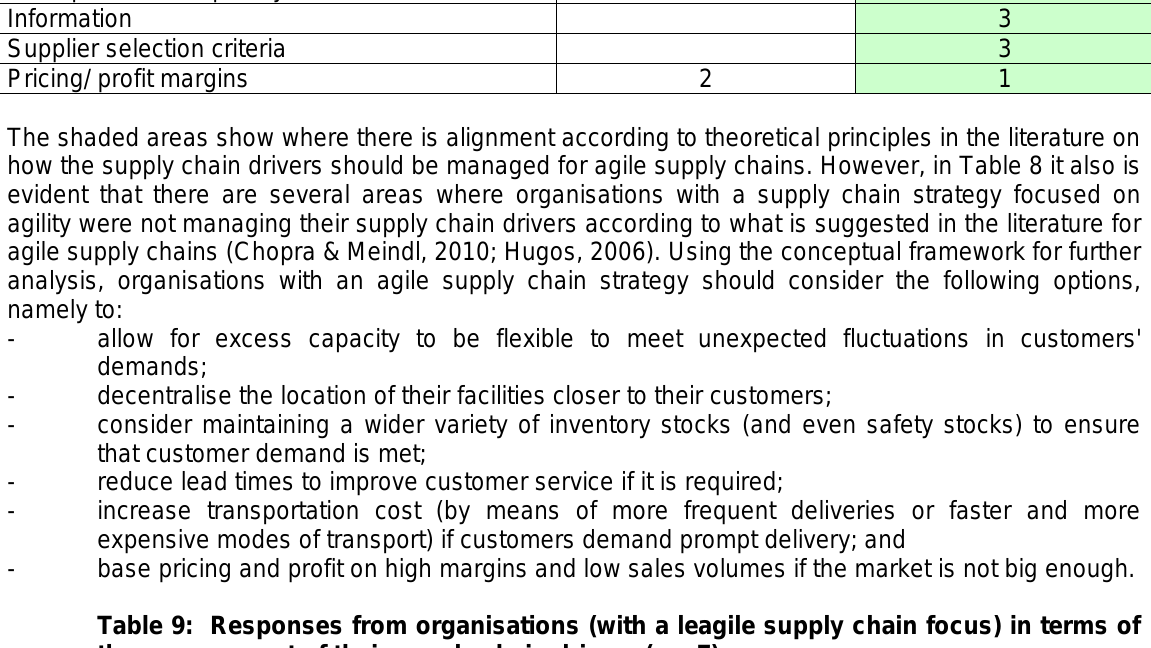
Table 9: Responses from organisations (with a leagile supply chain focus) in terms of the management of their supply chain drivers ( n = 7) SCD element (as identified in the supply chain Frequencies in terms of organisations with a drivers)